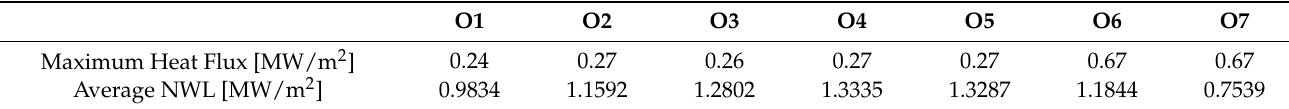
Table 1. Total Heat Flux and average NWL poloidal distribution. O1 O2 O3 O4 O5